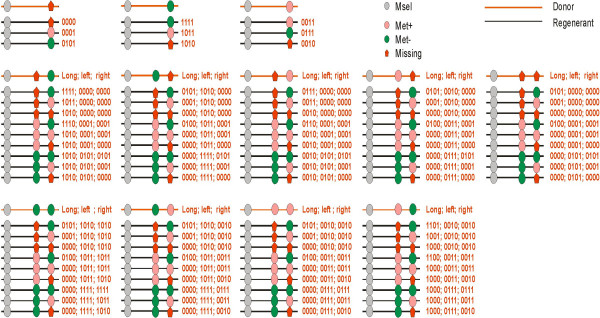
A schematic to interpret the outcomes on regenerant AFLP profiles of (epi)mutation events induced during tissue culture. The possible bases of AFLP profile changes induced during tissue culture are shown in terms of methylation of one or more sites and point mutation at the enzyme recognition site(s). All possible patterns were assigned a binary code. Top row: A single KpnI/Acc65I recognition site within the resolvable amplicon; lower two rows: a pair of KpnI/Acc65I sites within the resolvable amplicon. Grey circle – represents MseI site; pink circle – methylated site digested by KpnI but not Acc65I; green circle – non-methylated site digested by KpnI and Acc65I; red pentagon – former Acc65I/KpnI after mutation; red and black lines – donor and regenerant DNAs, respectively.